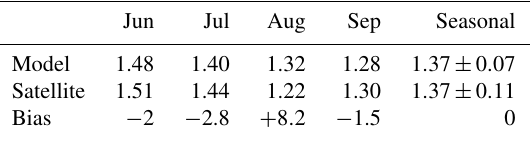
Table 2. Areal stock (TgC) of sea-surface tDOC computed over the Mackenzie Shelf (delimited by the 300m isobaths) from the model and satellite data. The bias (%) refers to the model data relative to the satellite data. The seasonal areal stock refers to the 4-month average ± SD. Jun Aug Sep